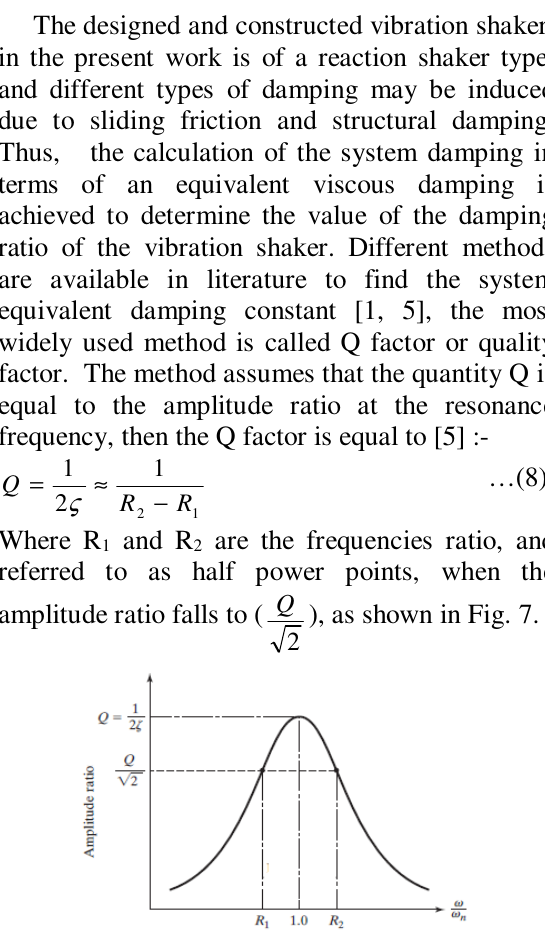
Fig. 7. Harmonic response curve showing half power points.